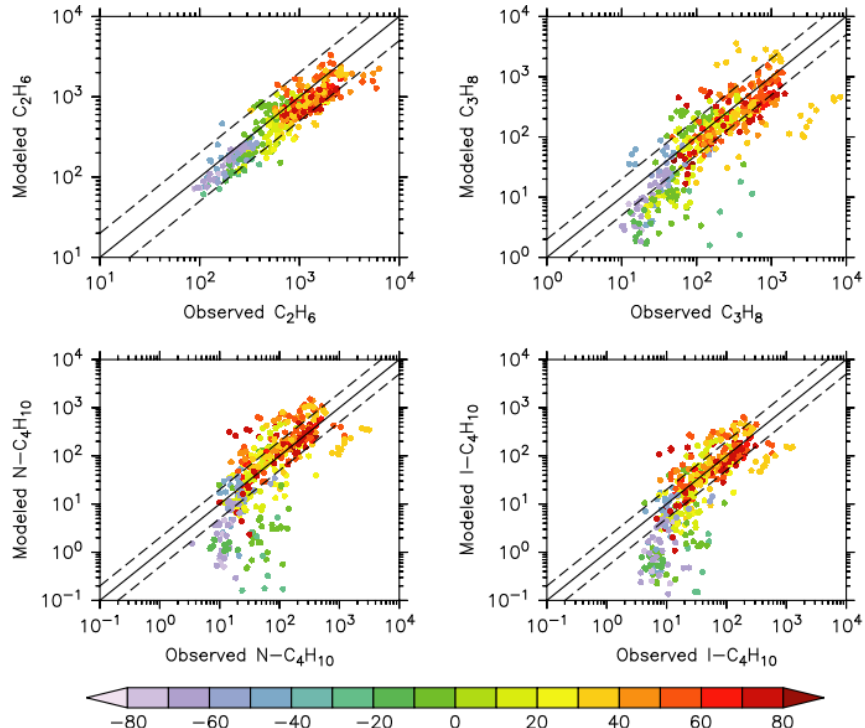
Figure 6. Scatterplot of measured and simulated surface alkanes mixing ratios at the NOAA/INSTAAR measurement stations for the year 2010 (in pmolmol − 1 ). The colour code denotes the latitude of the